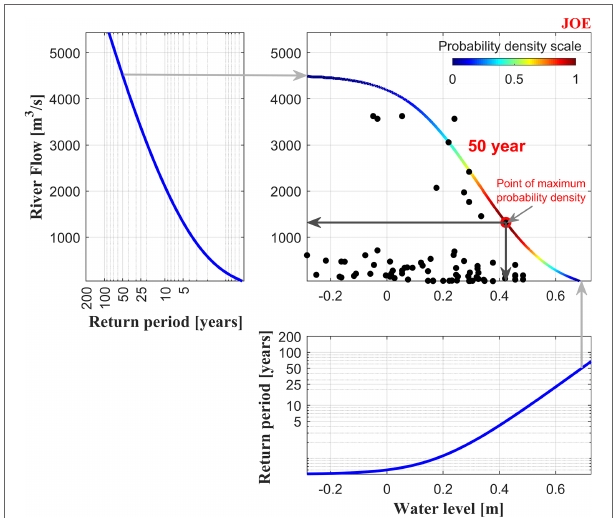
FIGURE 2 | Bivariate statistical analysis of flood drivers in Mobile Bay, AL. Marginal probability density of river flow (RF) and coastal water level (WL) with 50-year return level pairs around the corresponding iso-return period curve. Black scattered dots show bivariate occurrences of the flood drivers whereas red dot represents the point of maximum probability density based on the correlation structure of RF and